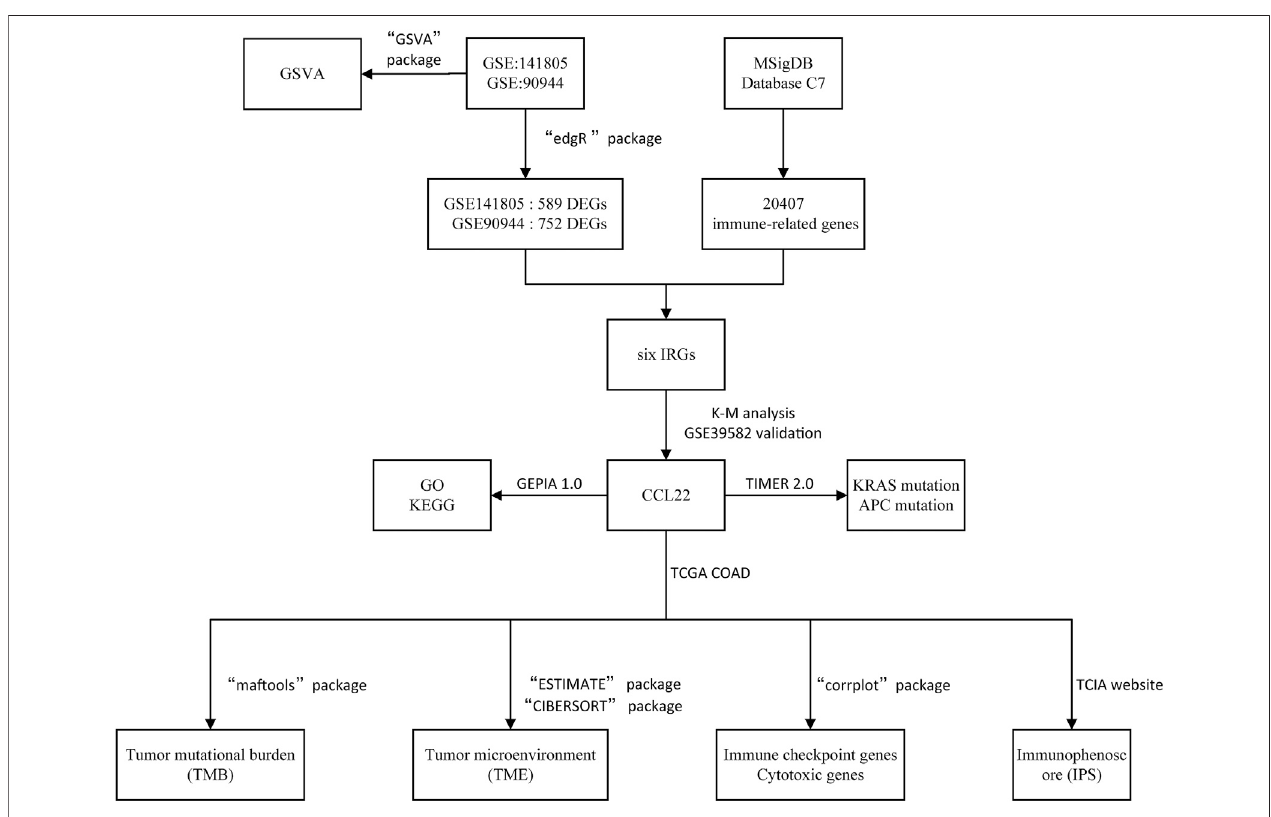
FIGURE 1 | Flow diagram of the present